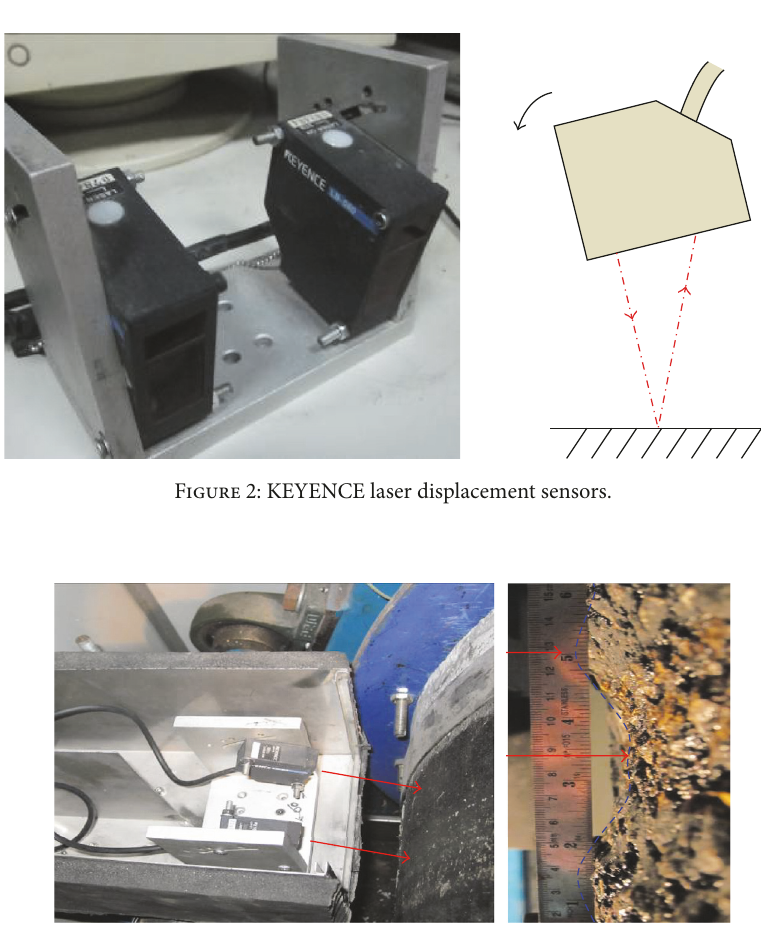
Figure 3: Setup of laser displacement sensors. The red arrows refer to the position where laser light is pointing at.